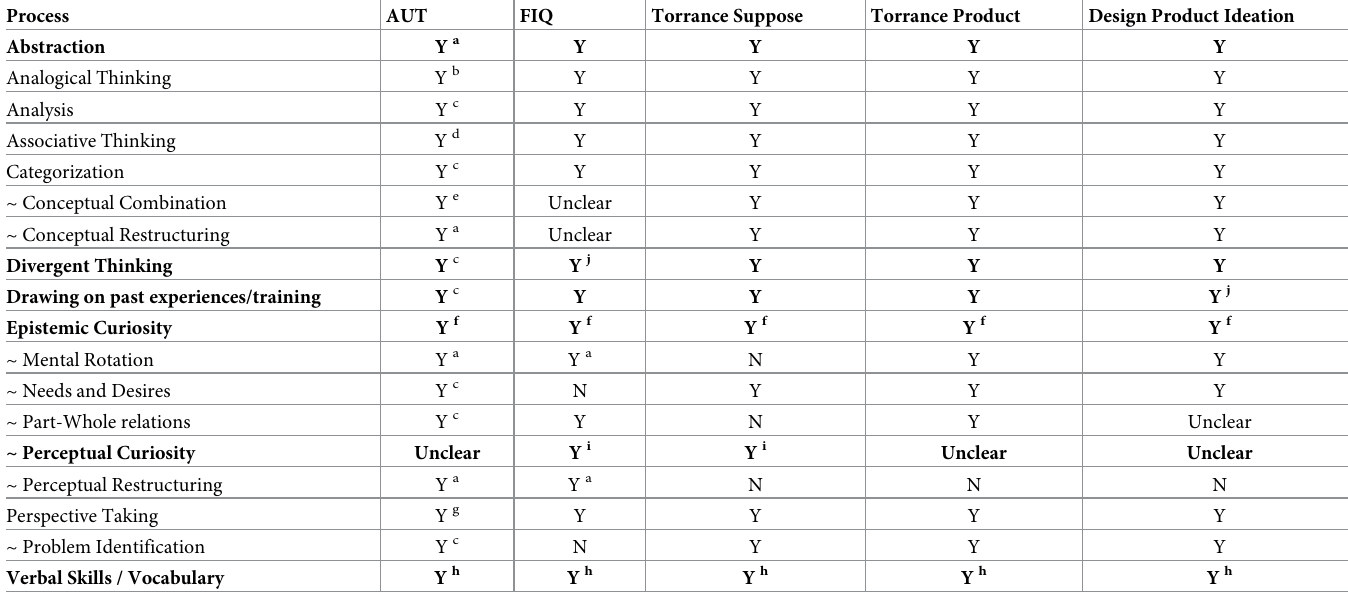
Table 1. Cognitive task analysis of creative processes for the four divergent thinking measures and Design Product Ideation